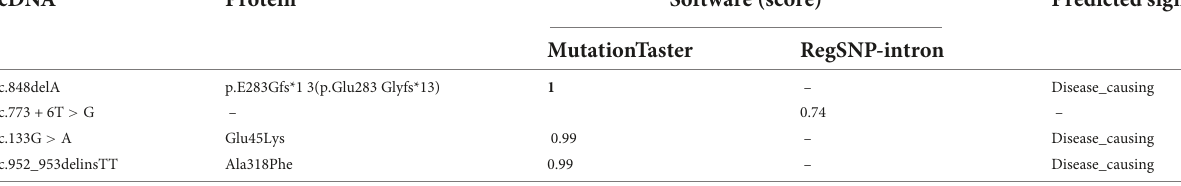
TABLE 4 Effect of novel gene mutation on protein function according to in silico analysis.